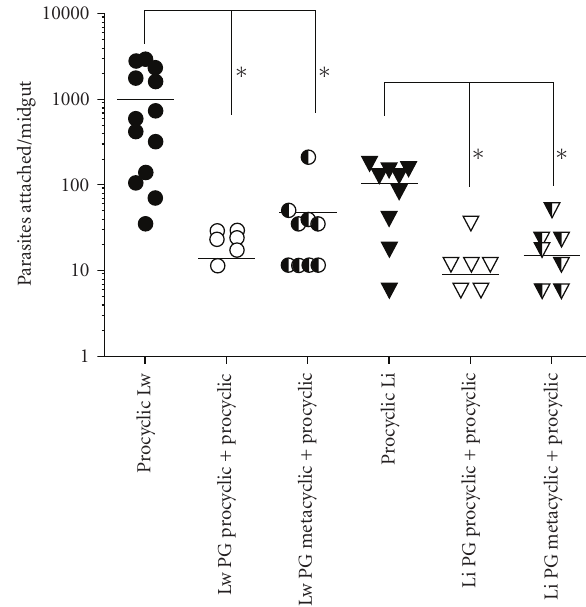
Figure 3: Inhibition of attachment of procyclic L. braziliensis to the midgut of L. whitmani (Lw) and L. intermedia (Li) in the presence of phosphoglycans (PGs) (10 μ g/mL). Midguts were incubated with PGs from procyclic and metacyclic L. brazilien- sis and further incubated with procyclic promastigotes. Control midguts were incubated only with procyclic promastigotes. PG procyclic: PG derived from procyclics; PG metacyclic: PG derived from metacyclics. ∗ P < . 0001. Data are the representation of two